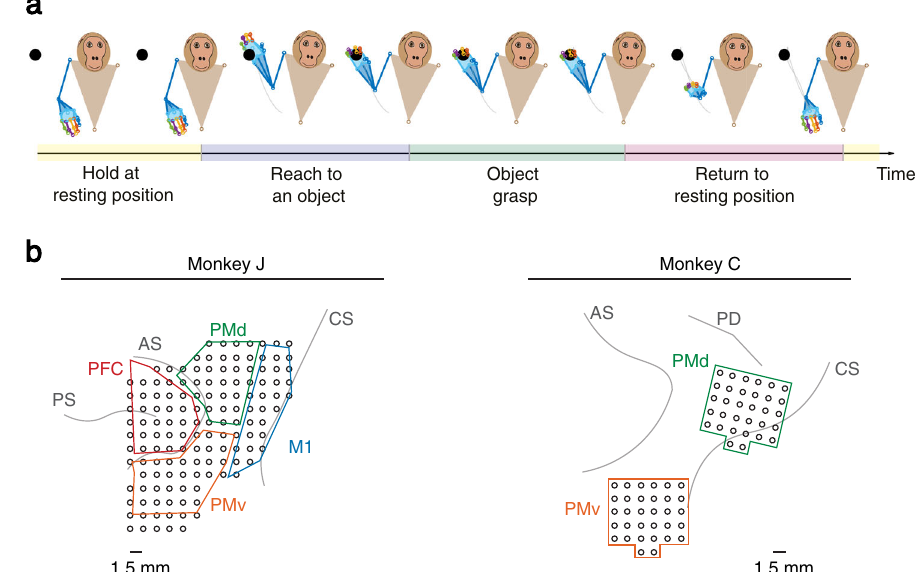
Fig. 1 Task set-up and recording regions for two non-human primates (Monkey J and Monkey C). a Both subjects performed a 3D naturalistic reach-and- grasp task in a 50 cm × 50 cm × 50 cm workspace. An object located on a wand was always present in the 3D workspace and visible to the monkey. The wand was continuously moved by the experimenter to random locations spanning a large spatial area in front of the subjects. Subjects naturalistically reached to the object (without a go cue), grasped it, and then returned to the resting position. They performed the reach-and-grasp continuously in time for the whole course of the recording session (without a trial structure). There was no go cue, no instructions as to when to reach, and no requirements on reach, hold and grasp durations as the subjects performed the task. Subjects performed reaches to the objects, decided on the hold durations, reach durations, and grasp durations naturalistically. We used motion capture technology using retrore fl ective markers to track 27 (Monkey J) or 25 (Monkey C) joint angles on the right shoulder, elbow, wrist, and fi ngers at each point in time. The picture is recreated from marker trajectories of a sample recording session for Monkey J. b Recording regions covered primary motor cortex (M1), dorsal premotor cortex (PMd), ventral premotor cortex (PMv), and prefrontal cortex (PFC) for Monkey J and covered PMd and PMv for Monkey C. Recording electrodes are shown as black circles. Brain sulci ( PS principal sulcus, AS accurate sulcus, CS central sulcus, PD precentral dimple) around the recording regions are shown by grey lines. The inter-electrode distance was 1.5